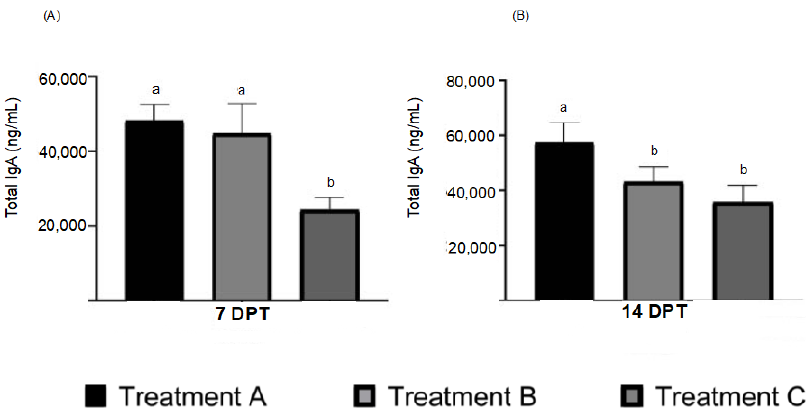
Figure 1. ELISA test of total S-IgA from lachrymal fluid of treatments A, B, and C. The concentration of total S-IgA from lachrymal fluid samples was determined using a commercial ELISA kit. ( A ). ELISA test results of total S-IgA in the lacrimal fluid were observed at 7 days post-treatment (DPT) on treatment A (virus-inactivated antigen), treatment B (HAr), and treatment C (PBS/A1). The re- sults at 7 DPT showed a statistical difference ( p < 0.05) in total S-IgA concentration in treatment A (48,334 ng/mL ± 4196 ng/mL) and B (44,759 ng/mL ± 8002 ng/mL) compared to treatment C (24,224 ng/mL ± 3496 ng/mL). ( B ) . ELISA test results at 14 DPT showed an increase in concentration of S- IgA on treatment A (57,486 ng/mL ± 7192 ng/mL) with a statistical difference ( p < 0.05) compared with treatment B (43,043 ng/mL± 5733 ng/mL) and treatment C (35,633 ng/mL± 6195 ng/mL). No statistical difference was observed in the cases of treatments B and C at 14 DPT. Literals indicate a statistical difference ( p < 0.05).